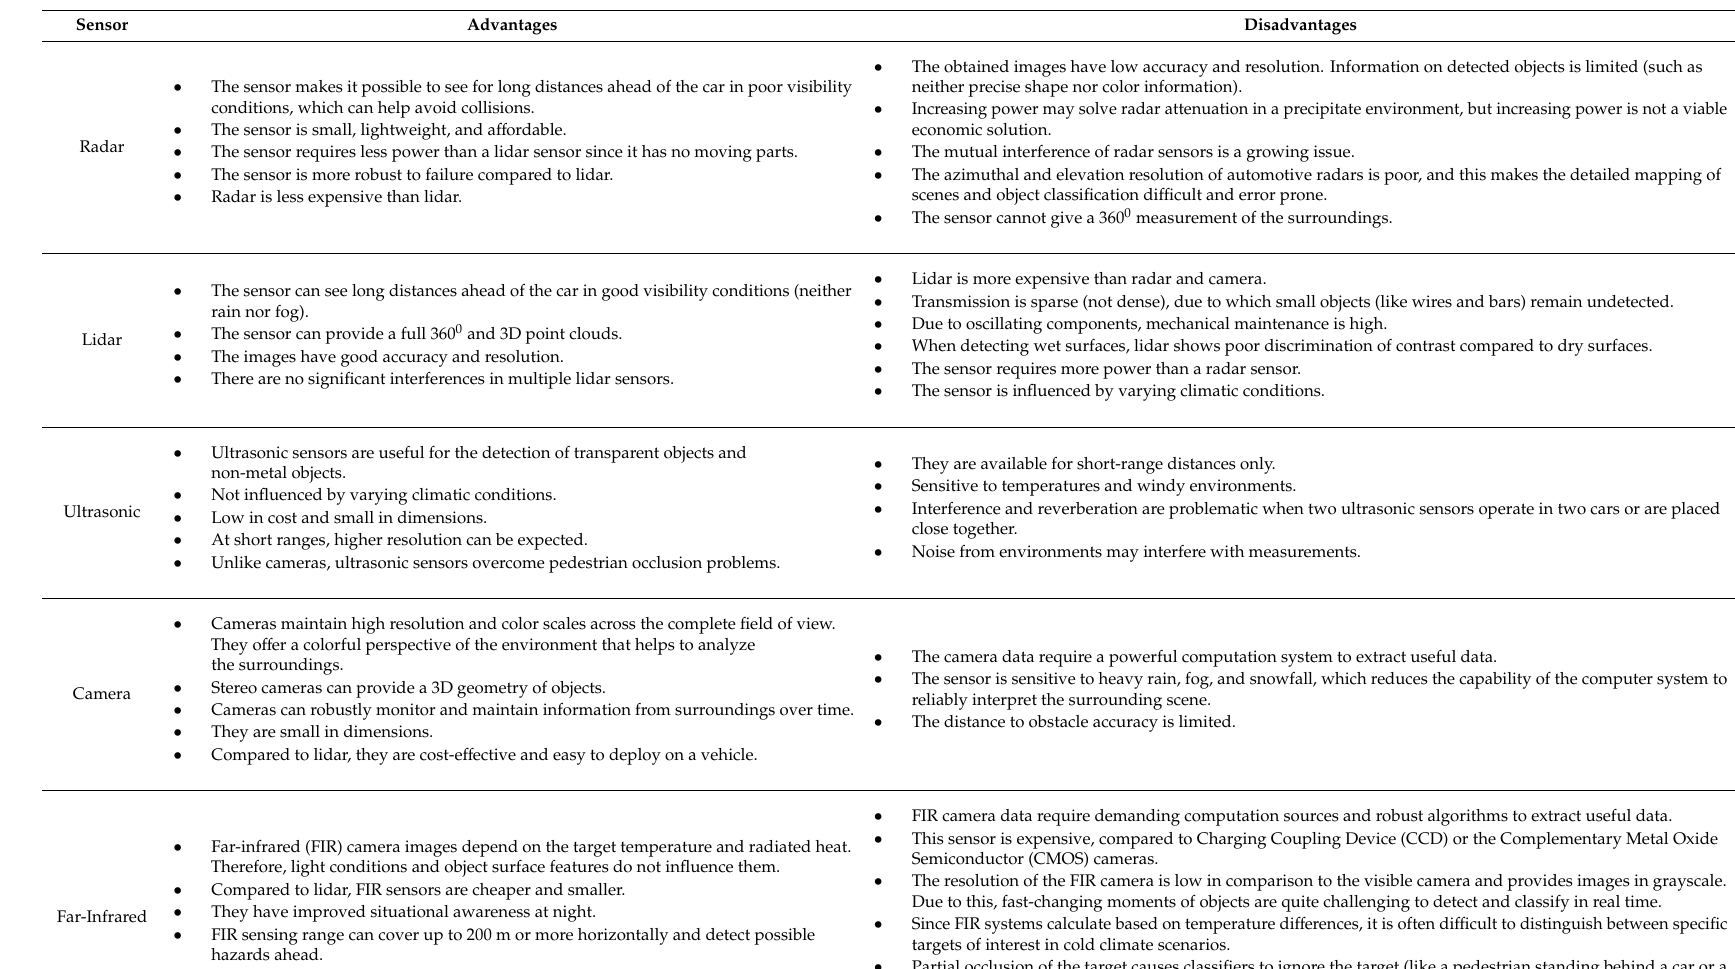
Table 3. List of advantages and disadvantages of perception